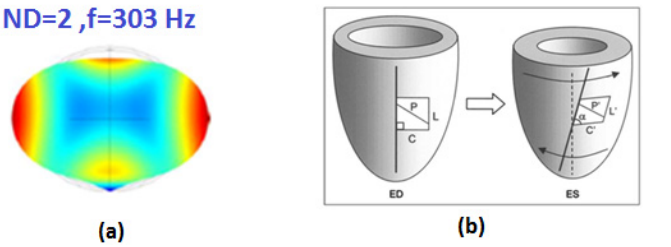
Figure 1. ( a ) Natural frequency of typical cell; ( b ) the rotation of left ventricular with speed ( Ω